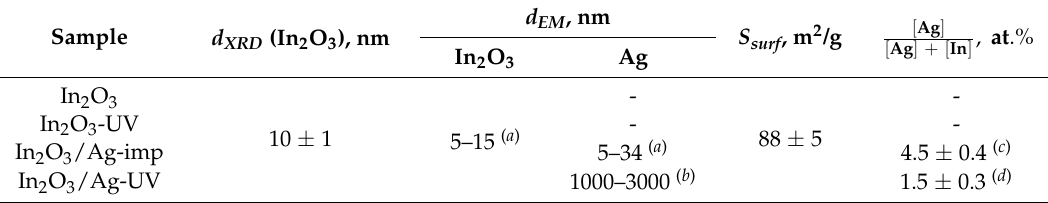
Table 1. Microstructure characteristics and composition of investigated samples.